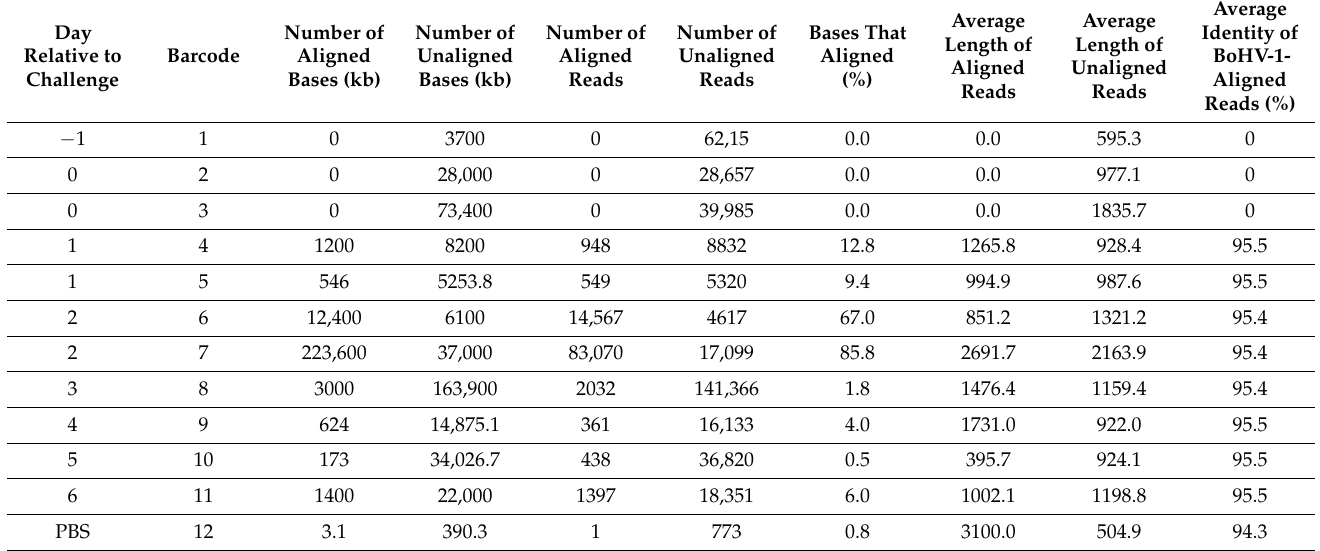
Table 5. Alignment of the BoHV-1 genome of FASTQ files with from swabs from calf